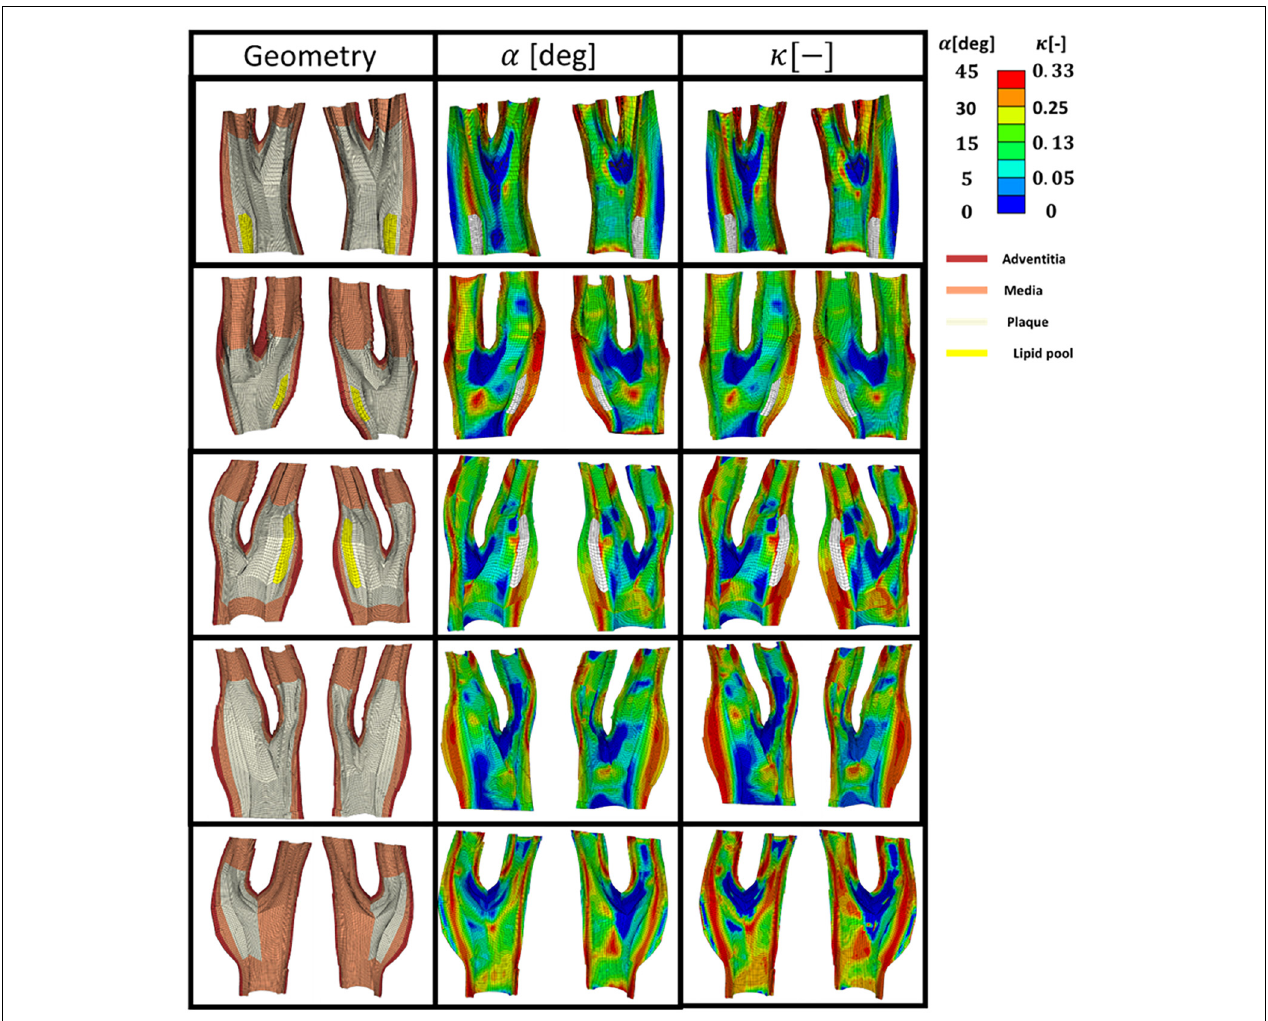
FIGURE 8 | The geometry of the five diseased carotid bifurcations obtained from symptomatic patients consisting of the adventitia and media layers (healthy arterial wall) and plaque burden made of plaque atheroma and lipid pool. The predicted angle of fibres with respect to the direction of the maximum principal stress is shown in the second column. The corresponding dispersion of the fibres in each family of collagen fibres is shown in the third